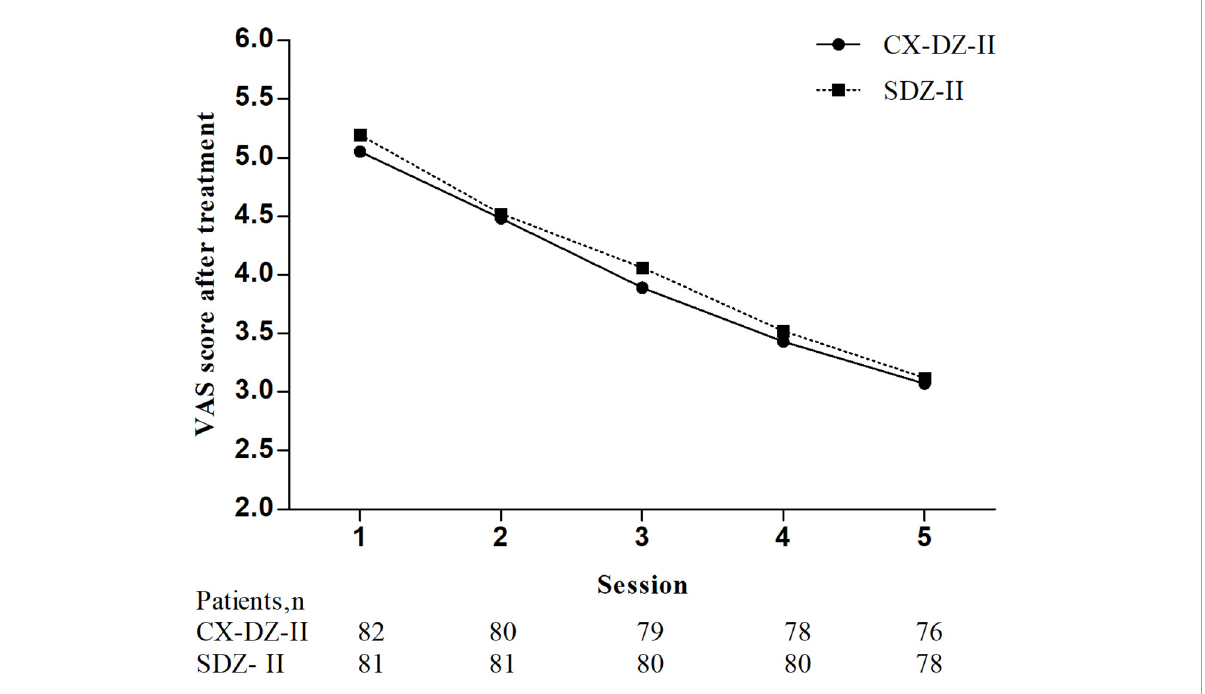
FIGURE2 The visual analog scale (VAS) score after treatment at 1 week. *The global test was significant ( p < 0.0001) and repeated-measures ANOVA with Greenhouse–Geisser correction was used. No significant group differences in 1 week were found ( Supplementary Table 3 ).